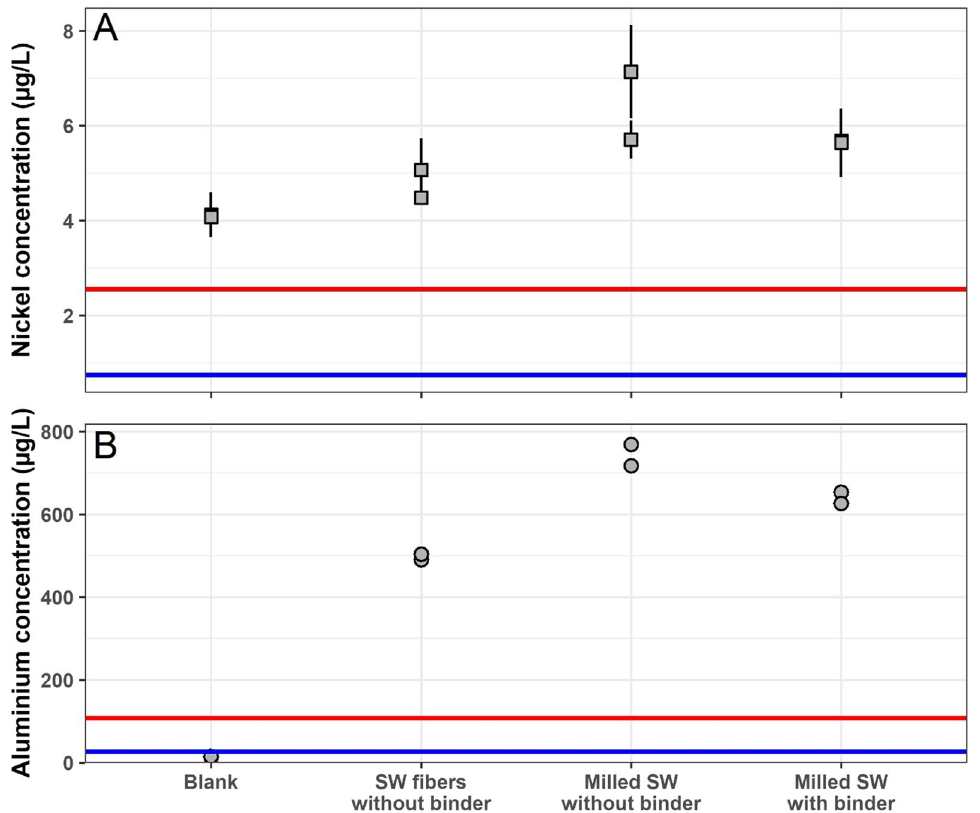
Fig. 1 Nickel ( A ; squares) and aluminum ( B ; circles) concentrations as mean and standard error of three measurements each for two experimental eluate replicates, as detected by ICP‑MS (for Ni) and ICP‑OES (for Al). Limits of detection (LOD; blue line) and limits of quantification (LOQ; red line) for the two elements are indicated. Eluates were prepared according to OECD No. 29 with 100 mg/L sample material and a 7‑day elution